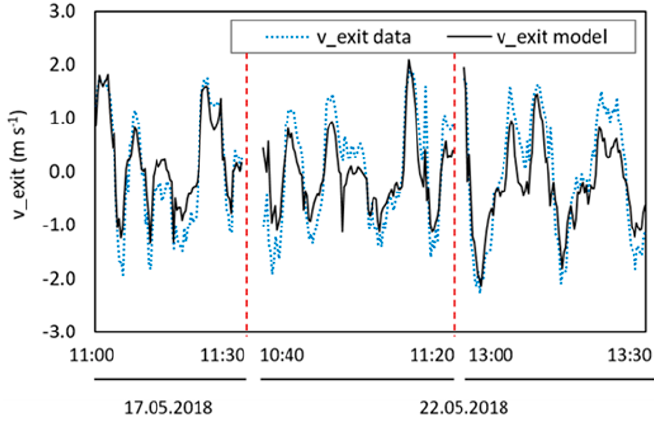
Figure 3. Plot of measured and modelled v_exit at the R das Flores venting stack for three monitoring periods (17.05.2018 and 22.05.2018).